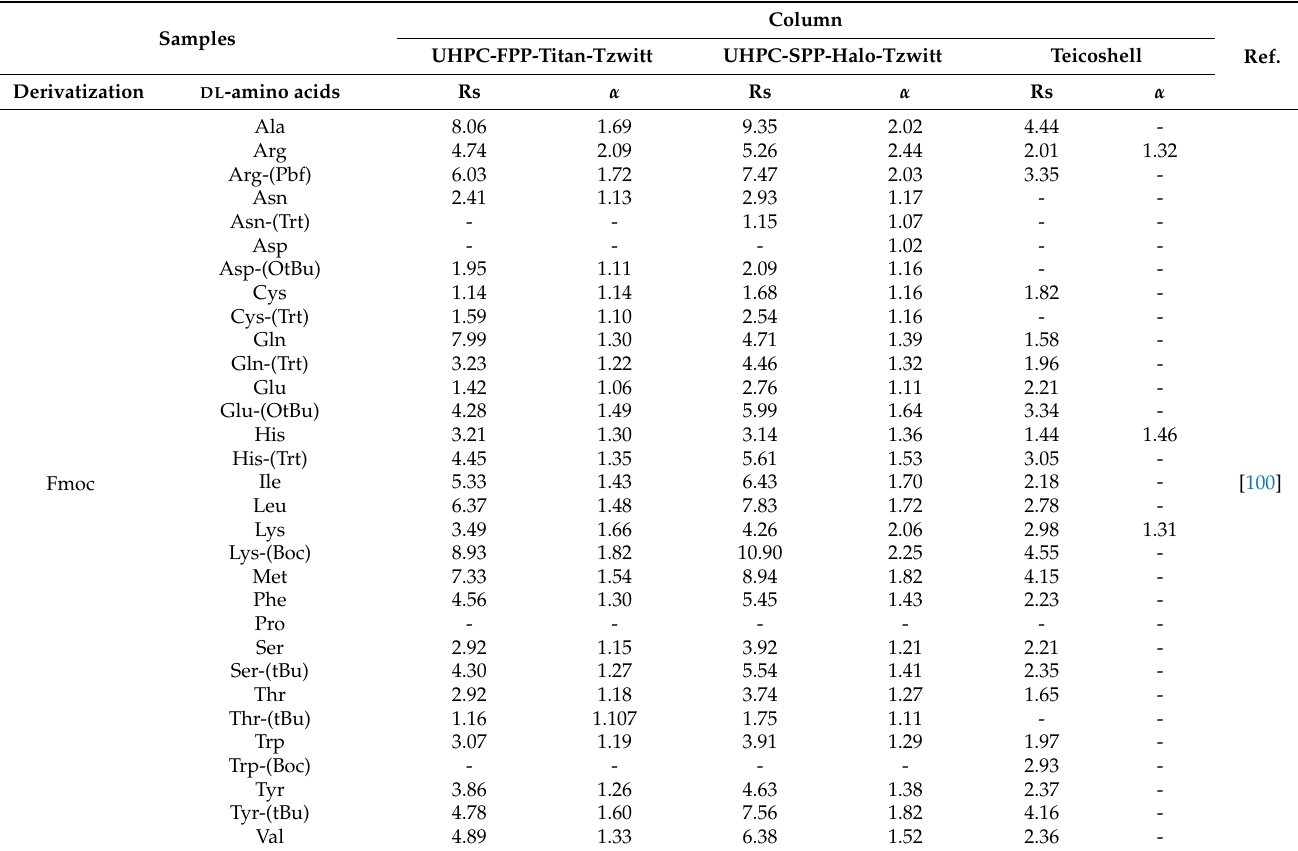
Table 6. Comparison of Fmoc-amino acid separation performances using the UHPC-FPP-Titan-Tzwitt, UHPC-SPP-Halo- Tzwitt and Teicoshell columns on MeOH-rich mobile-phase condition. Column Samples Ref.UHPC-FPP-Titan-Tzwitt UHPC-SPP-Halo-Tzwitt Teicoshell Derivatization DL -amino